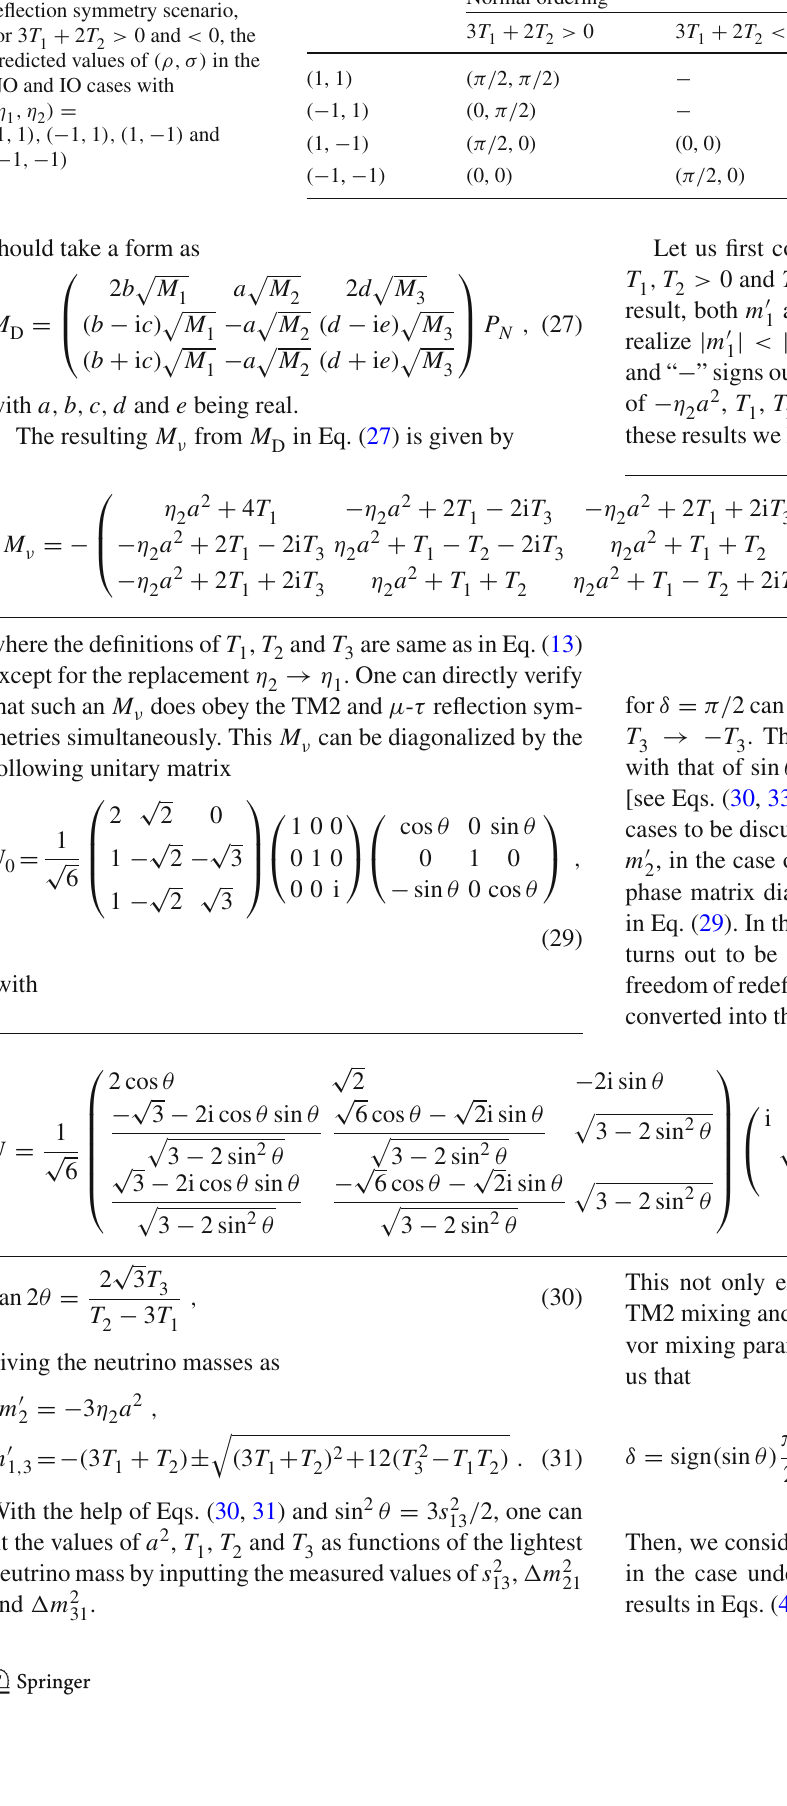
Table 2 In the TM1 μ -